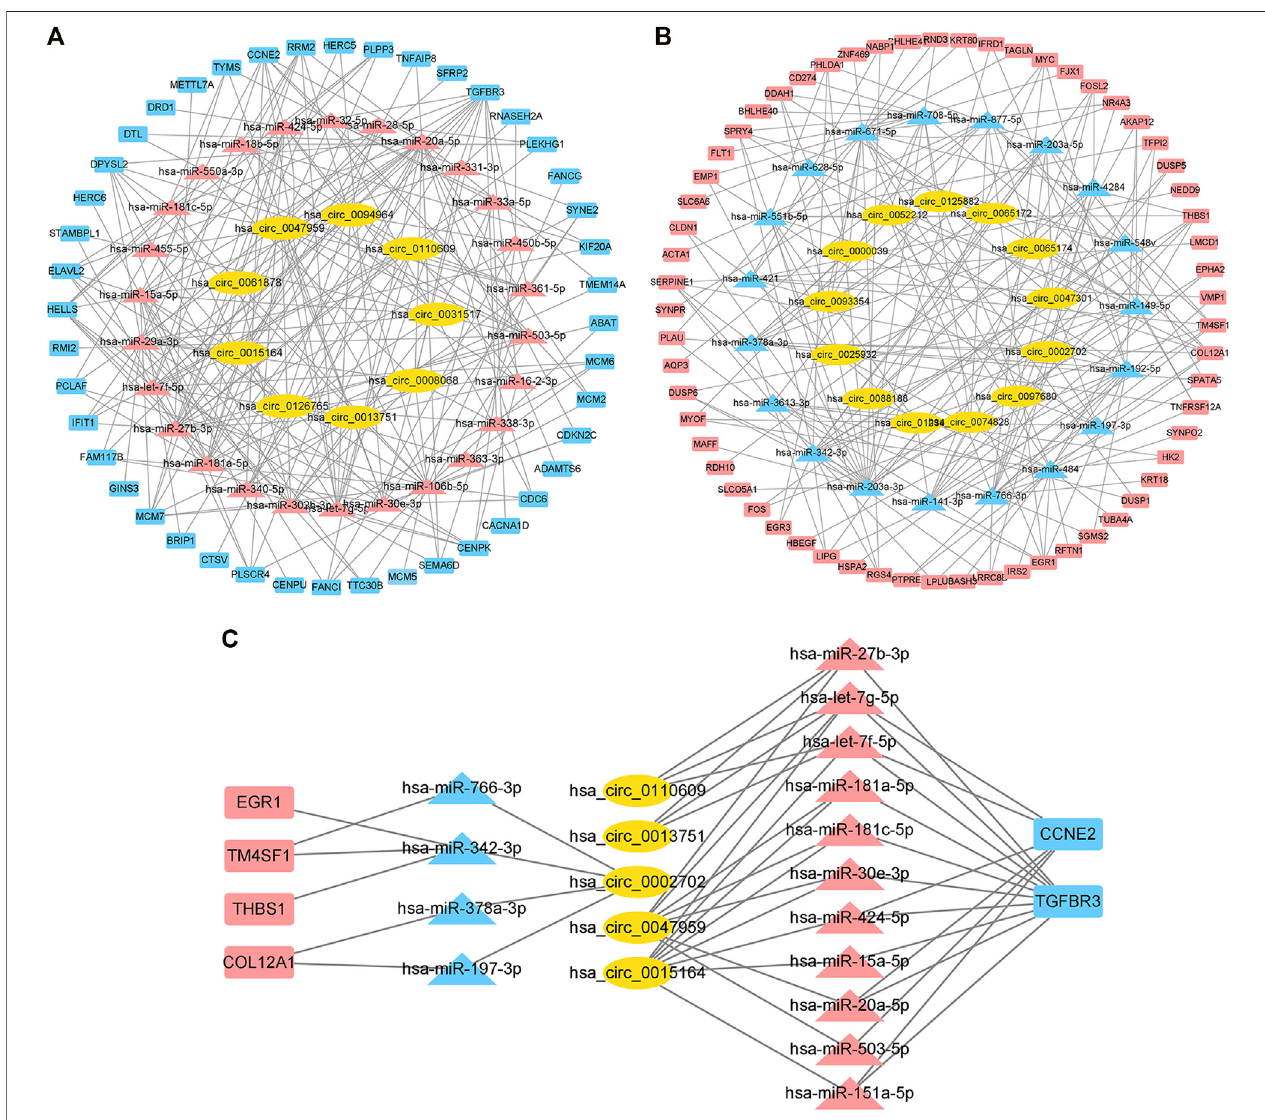
FIGURE5| ConstructionoftheceRNAnetworkandidenti fi cationofthehubceRNAnetworkincardiachypertrophy. (A) PositiveregulatoryceRNAnetwork.Yellow represents circRNAs, blue represents downregulated miRNAs, and red represents upregulated mRNAs. (B) Negative regulatory ceRNA network. Yellow represents circRNAs, red represents upregulated miRNAs, and blue represents downregulated mRNAs. (C) Key ceRNA network in cardiac hypertrophy.